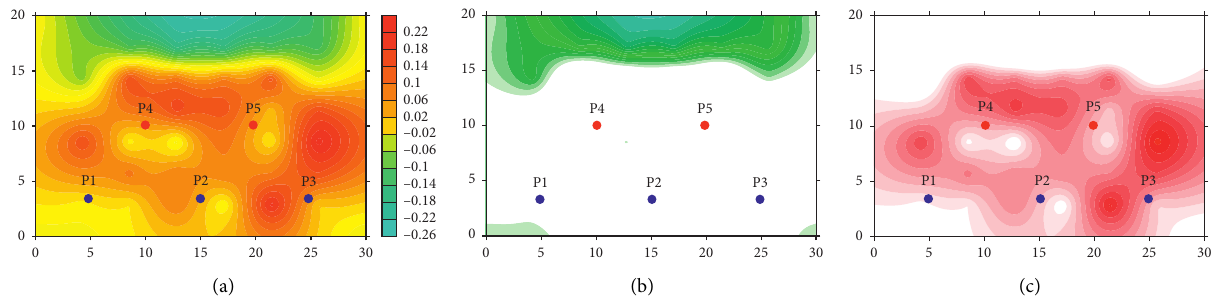
Figure 8: Difference diagram of the remaining oil saturation during binary flooding under different water energy conditions. (a) Whole region. (b) Negative region. (c) Positive